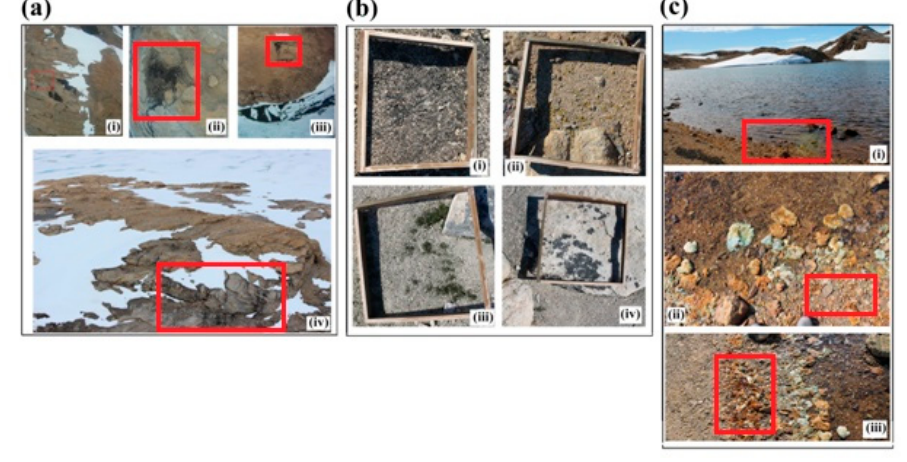
Figure 3. Examples of vegetation patches identified in the Larsemann Hills and environs. The study area is dominated by the macroscopic groups of moss cushions and carpets, crustose and foliose lichens, and microbial areas dominated by algae and cyanobacterial mats. Figure a (i)–(iv): Aerial images captured from 122 m height showing the vegetation patches across the study area. Vegetation patches are highlighted with red colored boxes. Figure b (i)–(iv): Types of vegetation (black and green colored) observed in the study area during field survey. The dimension of the wooden frame is equal to the resolution of PAN-sharpened WV-2 image (0.5 m × 0.5 m). Figure c (i)–(iii): Brown colored vegetation observed along water bodies in the study area during field survey. Brown vegetation patches are highlighted with red colored boxes.